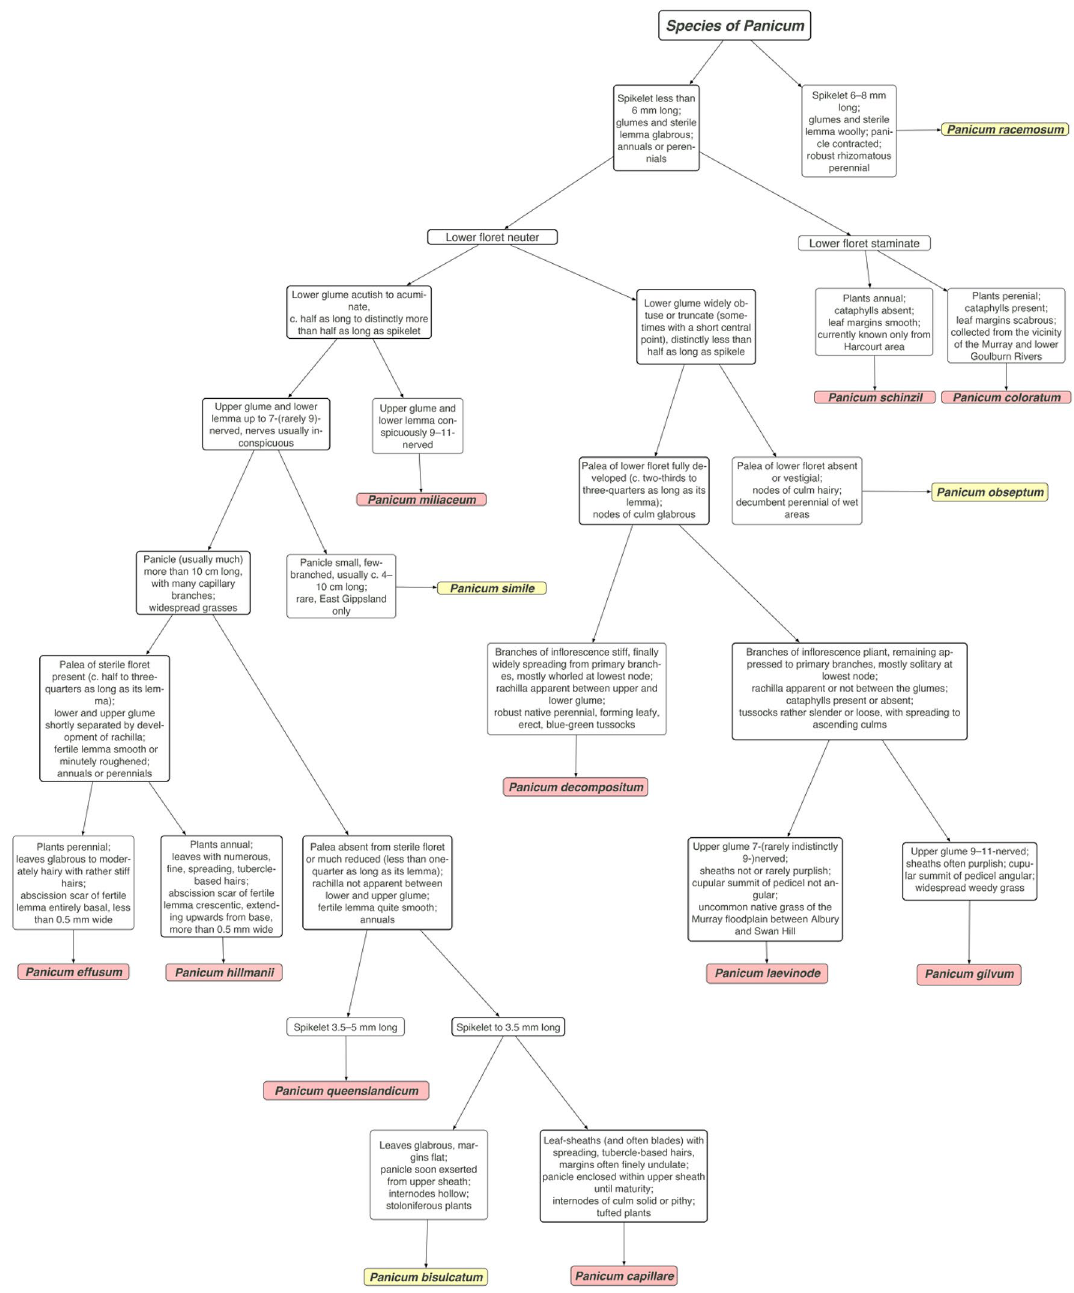
Figure 1. Taxonomic key for differentiation of selected Panicum species. Species included in this study are highlighted in pink, and other species are highlighted in yellow. 11 Modified from Walsh and